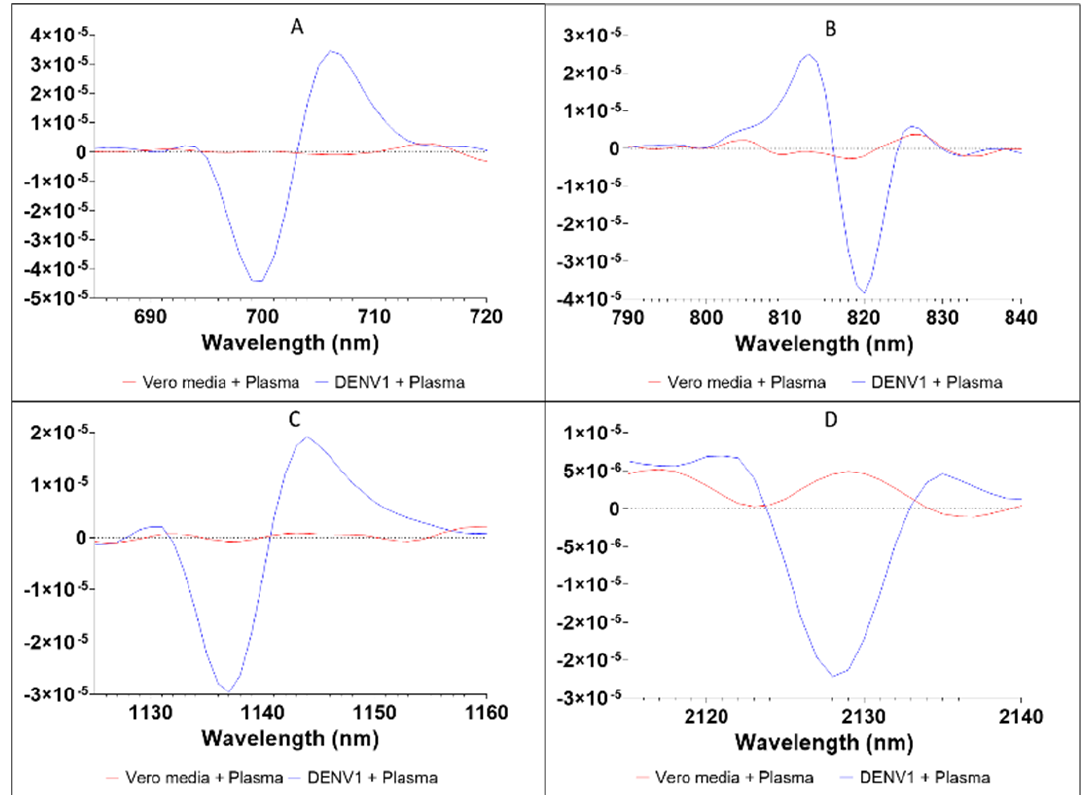
Figure 4. Second derivative NIR spectra of DENV1 in plasma samples. The red line indicates Vero media in plasma and the blue line indicates DENV1 in plasma. Panel ( A ) displays the wavelength range from 685 to 720 nm with DENV1 prominent peaks at 700 and 706 nm. Panel ( B ) displays the wavelength range from 790 to 840 nm with DENV1 prominent peaks at 812 and 819 nm. Panel ( C ) displays the wavelength range from 1125 to 1160 nm with DENV1 prominent peaks at 1130, 1137 and 1142 nm. Panel ( D ) displays the wavelength range from 2115 to 2140 nm with a DENV1 prom- inent peak at 2127 nm. Table 4. A summary of prominent wavelengths identified for DENV1 in plasma and their indicative functional groups from the literature [57–60].